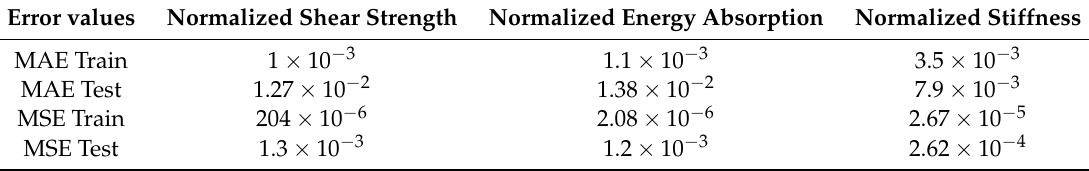
Figure 9. Real and predicted normalized load values versus the various A o /A s . Table 5. The mean absolute and mean squared errors (MAE and MSE) results of the proposed model for training and testing procedures.